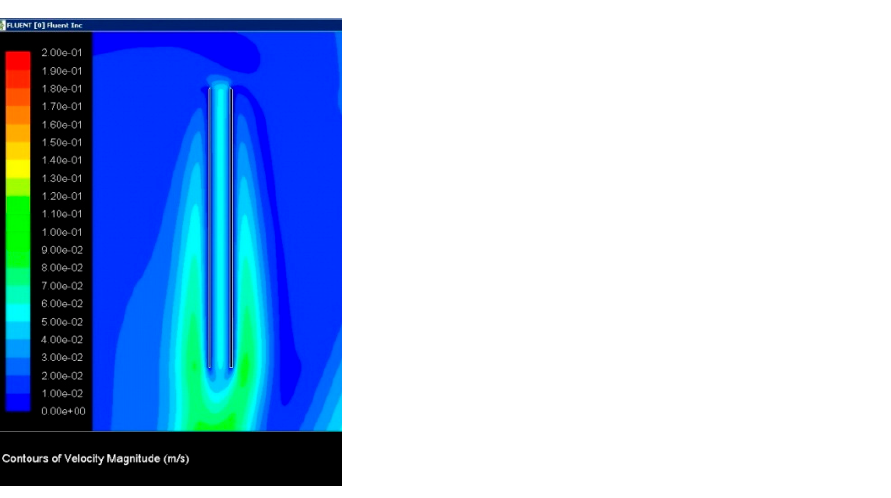
Figure 14. The contours of velocity (m/s) at spacing of 5 mm and rib height 70 mm.